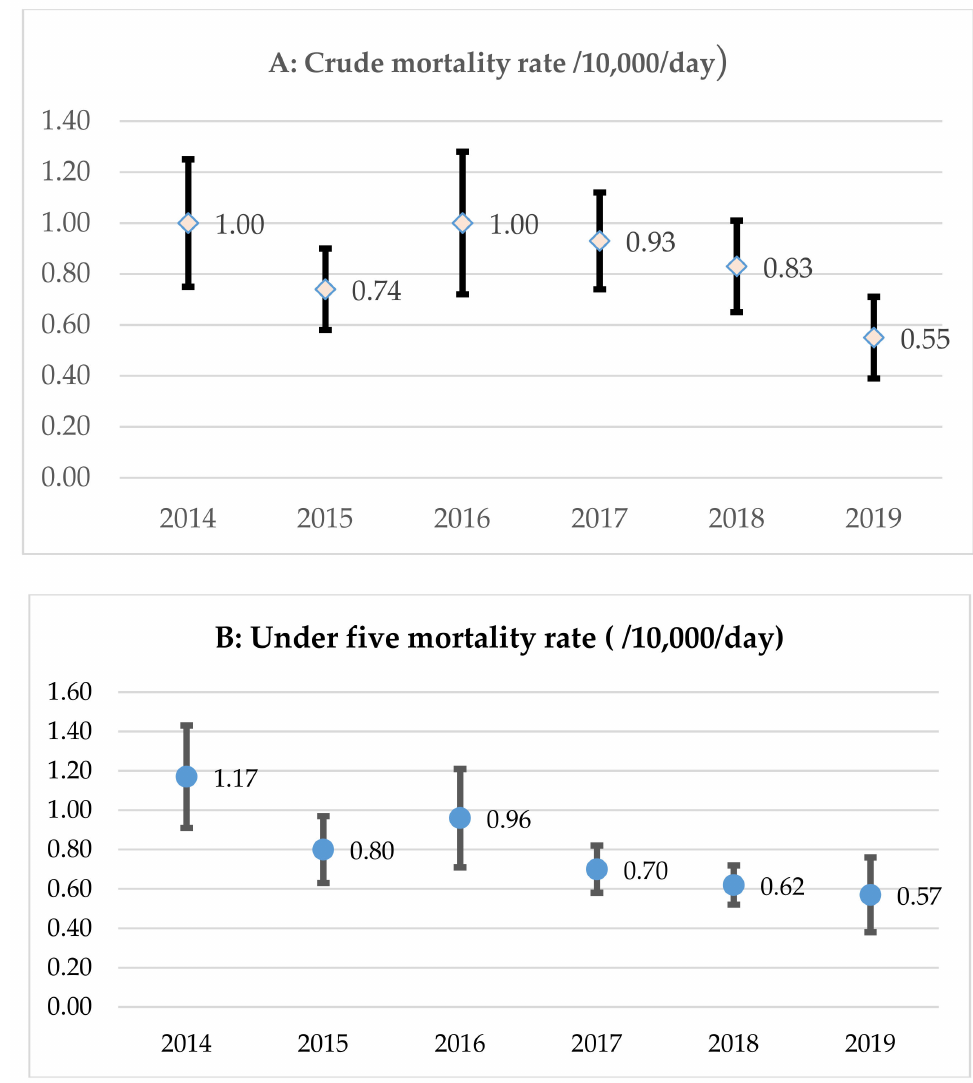
Figure 1. Trends in crude mortality and under five mortality